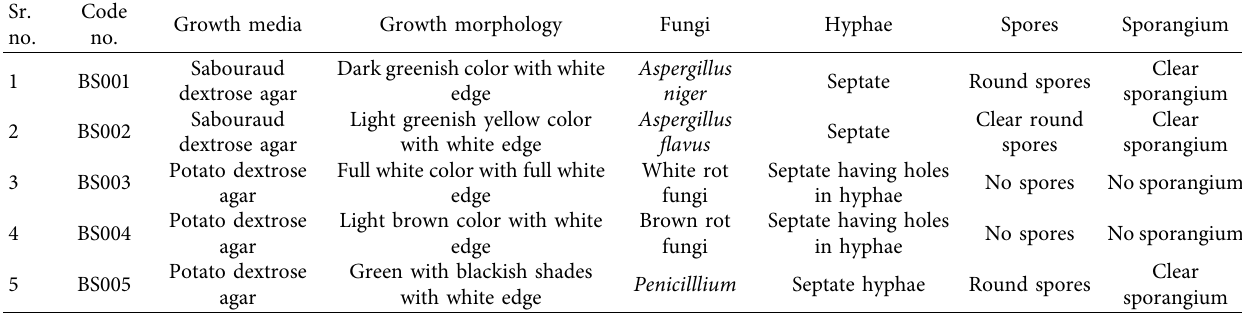
Table 1: Microscopic and macroscopic identification of the fungal isolates from waste disposal sites.